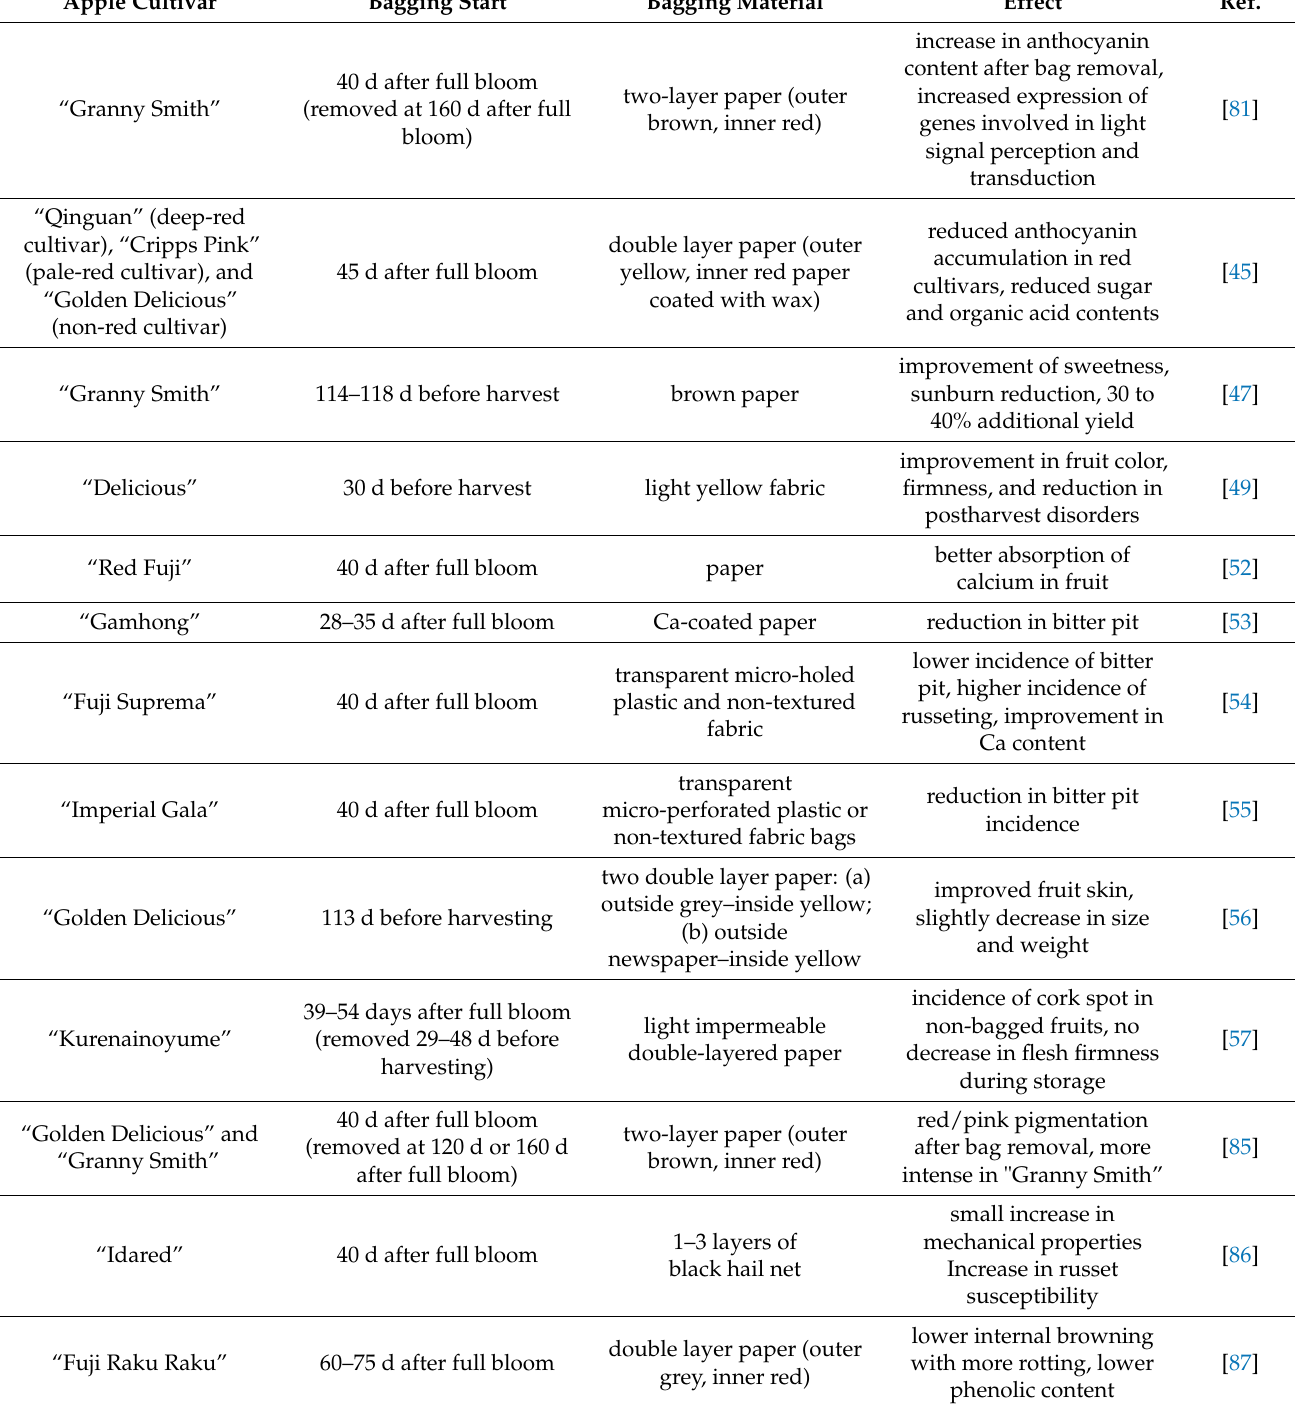
Table 2. The influence of bagging on physiological disorders, color and quality of apple fruits. Apple